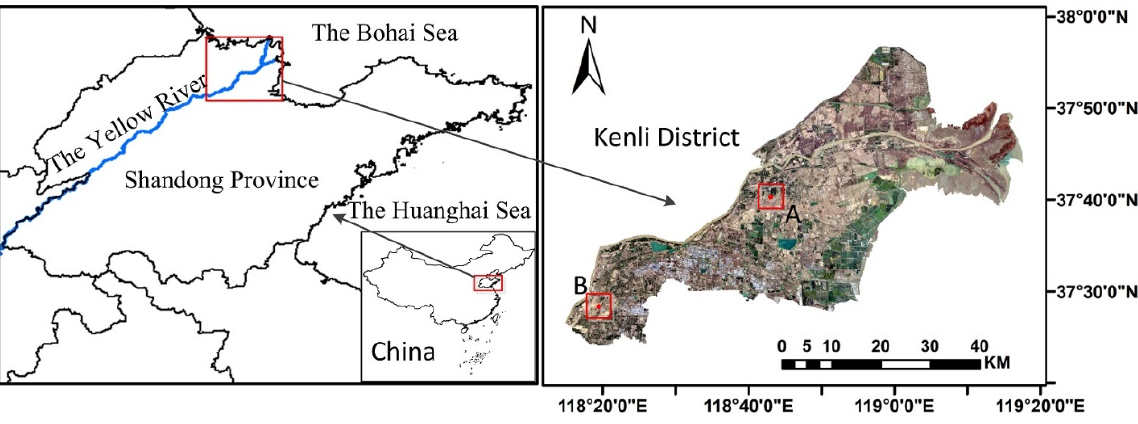
Figure 1. Study area and test areas A and B.